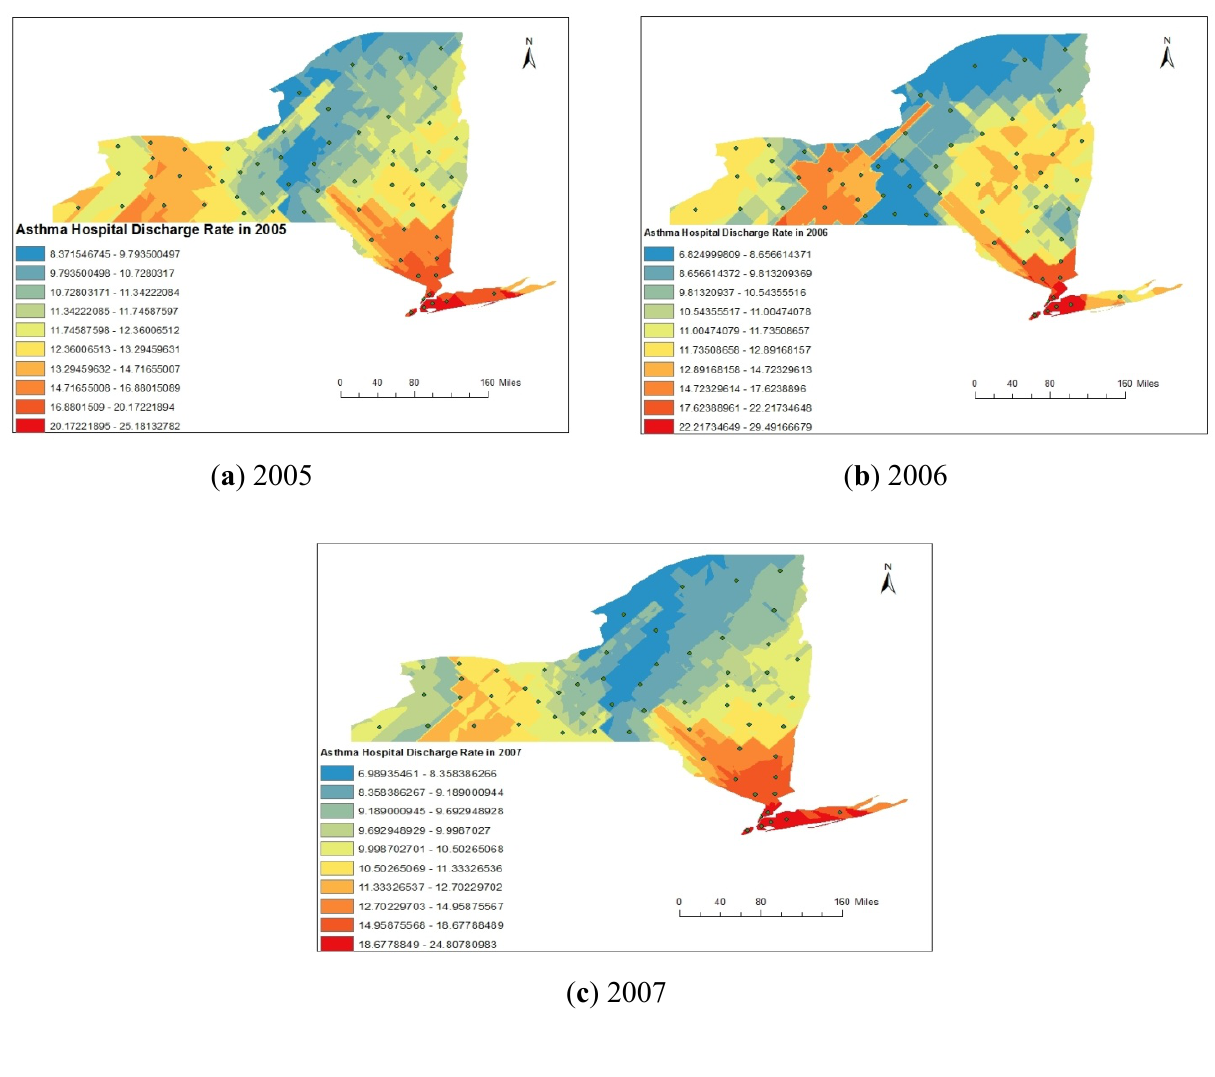
Figure 8. ( a – c ) Spatial distribution of asthma discharge rate (ADR) during 2005 to